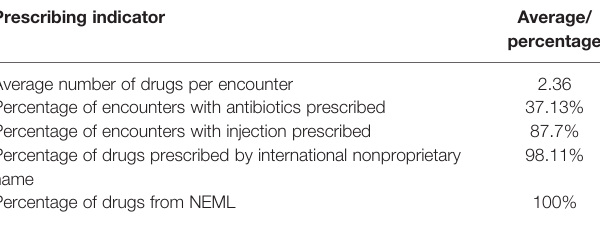
TABLE 4 | Drug prescribing indicators for the emergency department of HFSUH, Harar, Ethiopia 2018 (n = 342). Prescribing